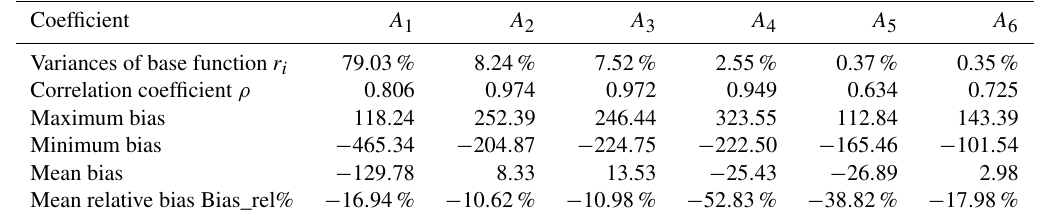
Table 3. Variances of base function, correlation coefficient, and bias statistics among coefficients A 1 – A 6 of GIM-TEC and IRI-TEC.